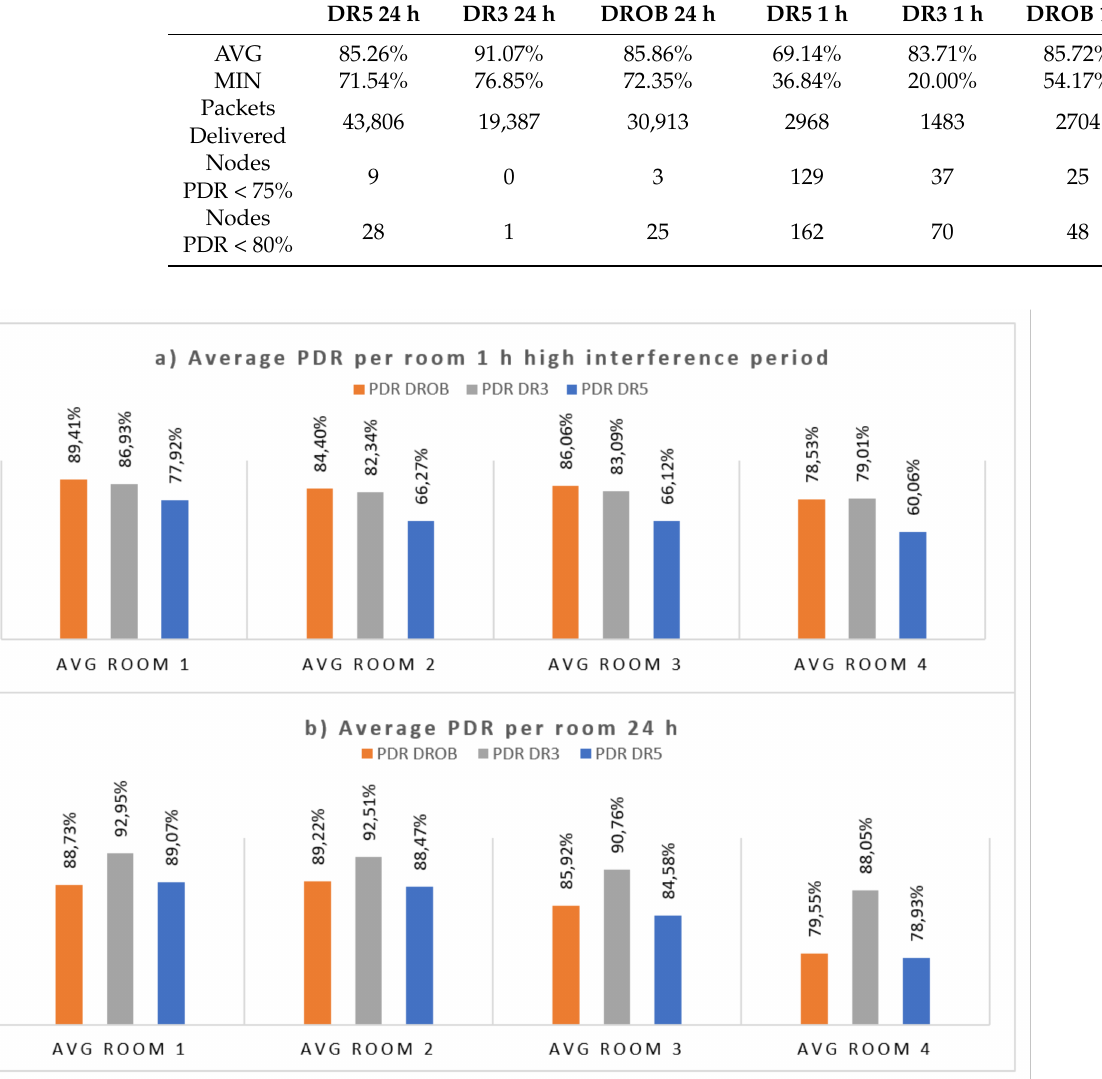
Figure 12. Average PDR per room during the 1 h of high frequency interference ( a ), and during 24 h ( b